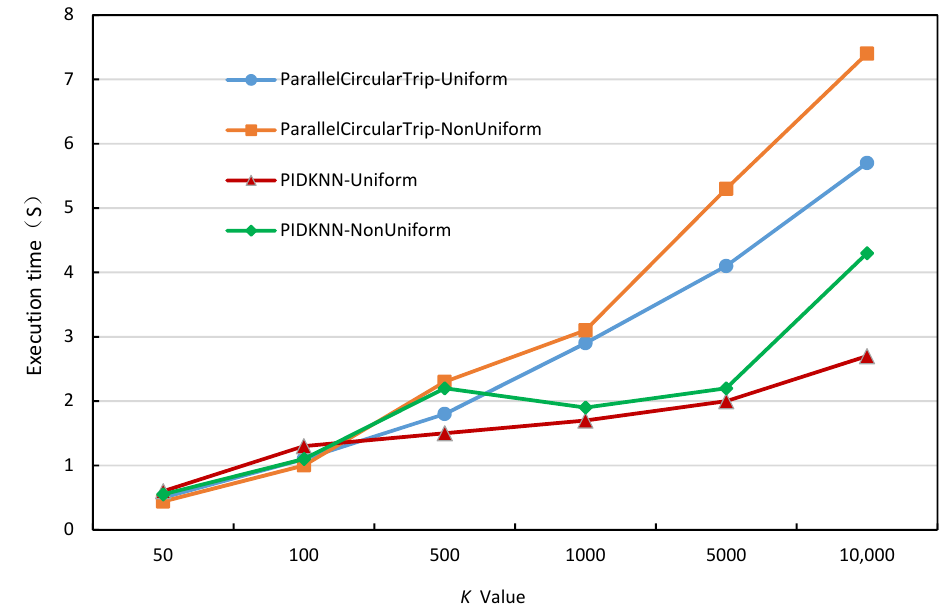
Figure 10. Execution time under different k.